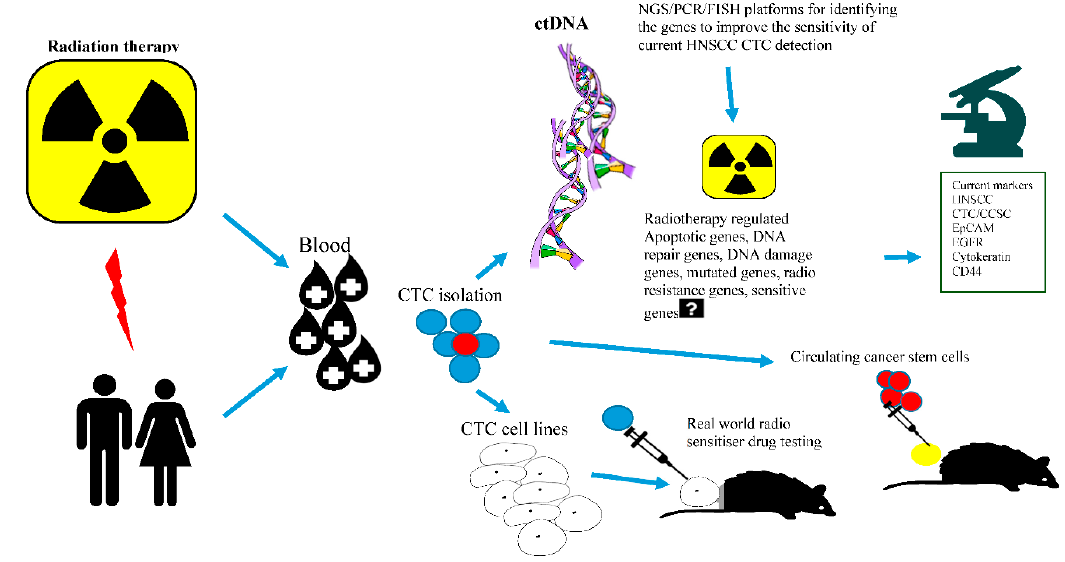
Figure 4. New developments and progress towards unexplored CTC-Cancer research. Figure generated using free smart draw templates and examples program.